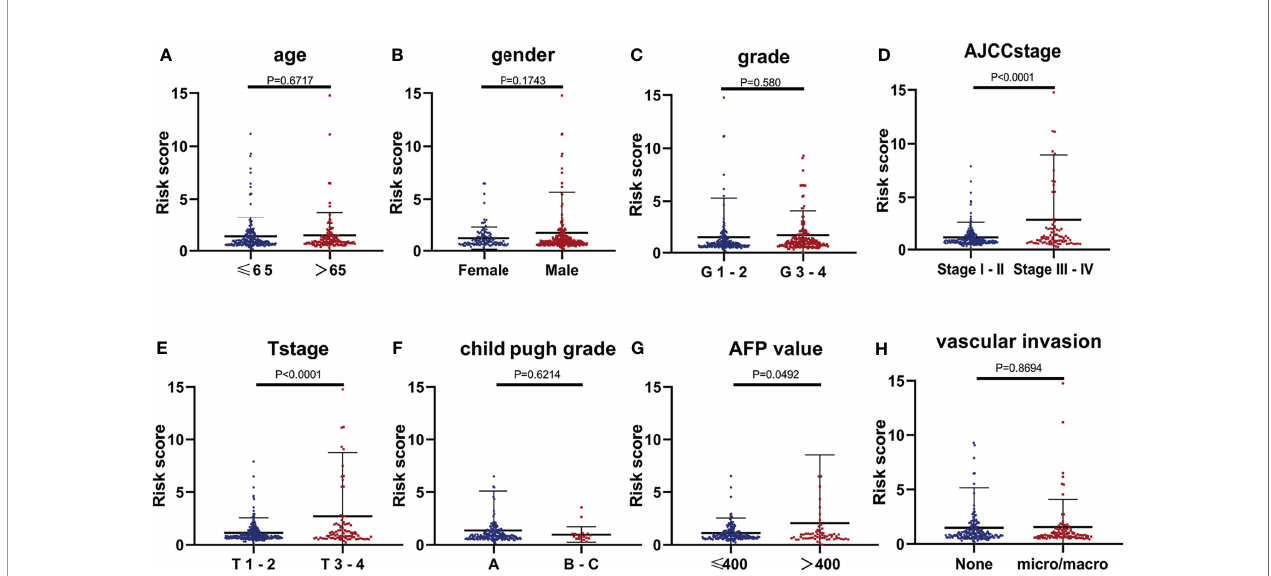
FIGURE 5 | The relevance of the CCS-based risk score to each clinical feature. (A) Age (P = 0.6717), (B) gender (P = 0.1743), (C) grade (P = 0.580), (D) AJCC stage (P < 0.0001), (E) T stage (P < 0.0001), (F) Child – Pugh grade (P = 0.6214), (G) AFP value (P = 0.0492), and (H) vascular invasion (VI; P =